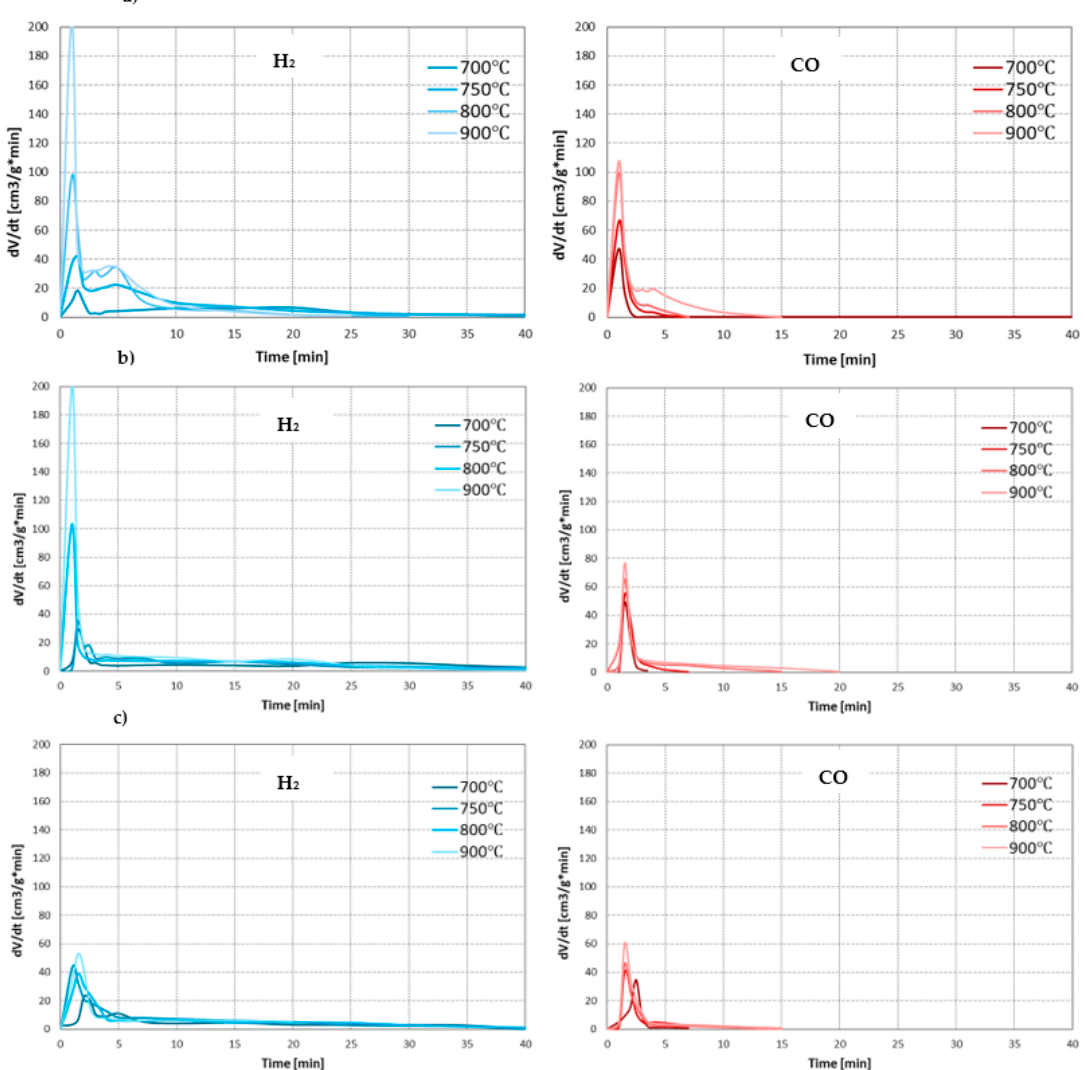
Figure 3. Changes in the formation rates of H 2 and CO during steam gasification of RDF at various temperatures and under: ( a ) 0.5 MPa; ( b ) 1 MPa; ( c ) 1.5 MPa.